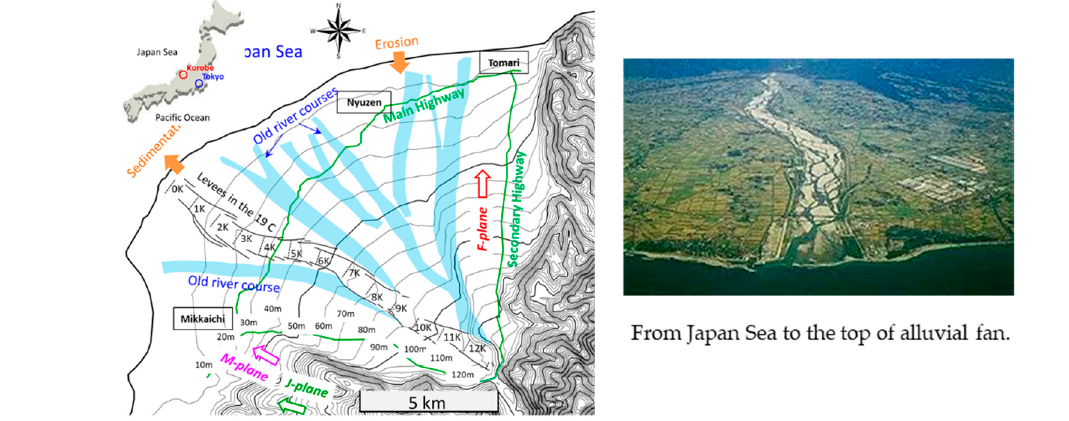
Figure 1. Kurobe Alluvial Fan.